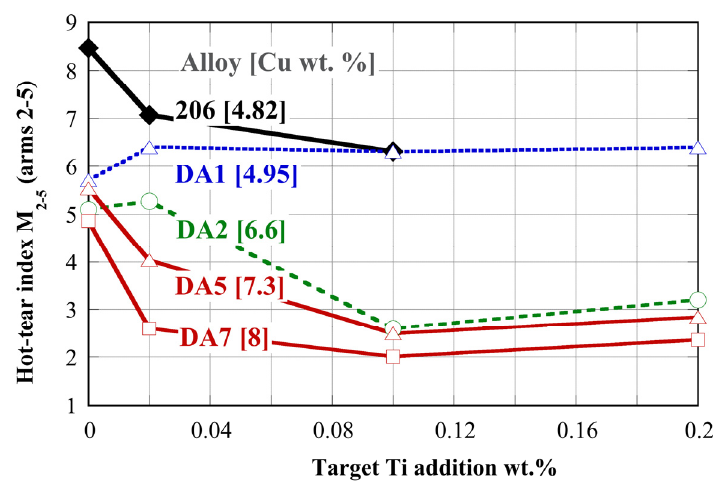
Figure 9. The hot-tearing index as a function of wt.% Ti addition for alloys 206, DA1, DA2, DA5, and DA7, all with low levels of Fe and Si impurities. Metals 2020 , 10 , 430 15 of 18